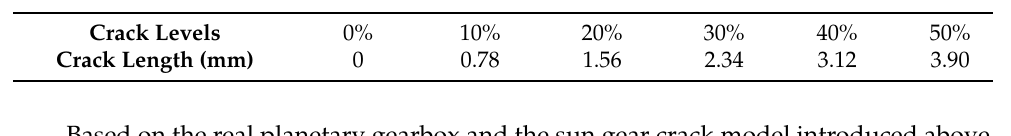
Table 3. Crack levels and the corresponding